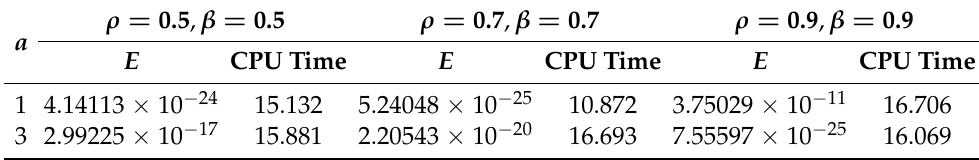
Table 4. Residual error of Example